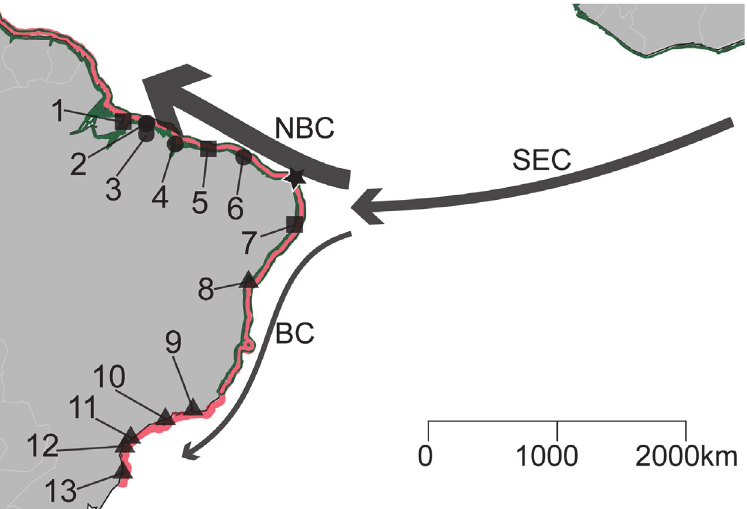
Fig 1. Geographic distribution of A . germinans and A . schaueriana samples along the Brazilian coast. A map of the South Atlantic showing the geographic distribution of A . schaueriana (red) and its sympatry region with A . germinans (green and red). Squares and triangles indicate locations where only A . germinans and or A . schaueriana , respectively, presented reproductive branches during sampling. Circles represent locales where both species presented flowers. The star indicates the northeastern extremity of South America. Sampling locations are displayed according to Table 1. Arrows denote the following near-surface ocean currents that influence the sampling range: the South-Equatorial (SEC), North Brazil (NBC) and Brazil currents (BC). Arrow sizes and line widths illustrate the mean current speed [61].